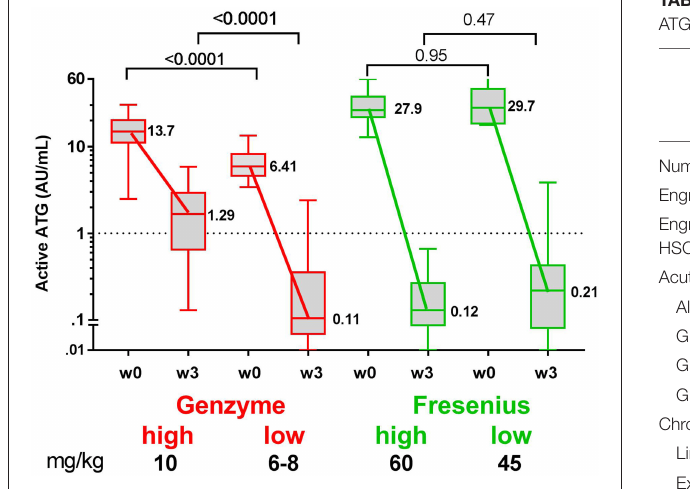
FIGURE 3 | Box plots of serum/plasma concentration of active ATG in ATG-GENZ (Genzyme) and ATG-FRES (Fresenius) treated patients depending on the given total ATG dose. At week 0 (day of graft infusion) the ATG-GENZ patients receiving a total ATG dose of 10 mg/kg had a significantly higher serum/plasma level of active ATG than the 6–8 mg/kg receiving patients. Active ATG in ATG-FRES treated patients was at week 0 comparable between 45 and 60 mg/kg total ATG dose receiving patients and higher than in ATG-GENZ treated patients. At week + 3 post-HSCT the serum/plasma level of active ATG in ATG-GENZ treated patients was still strongly dependent on the given dose (1.29 and 0.11 AU/mL), but the active ATG concentration in ATG-FRES treated patients was comparably low regardless of ATG dosing (0.12 and 0.21 AU/mL, respectively). The horizontal dashed line at 1 AU/mL is the highest serum/plasma concentration at which T-cells can recover.